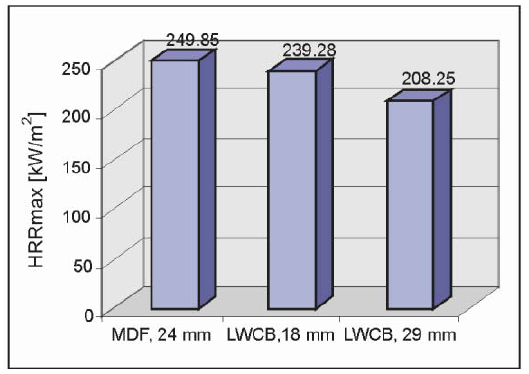
Fig. 7. The mean value of maximal heat release rate (HRR max ) when exposed to the surface heat flow of density 70 kW/m 2 for different tested boards